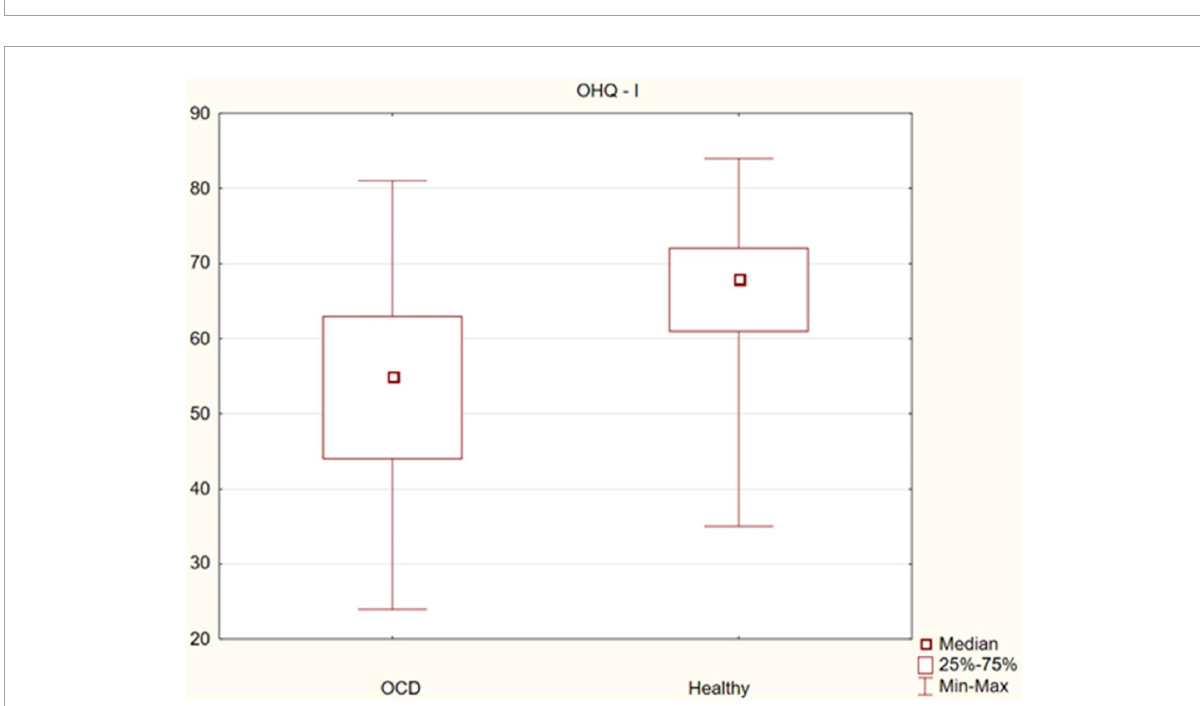
FIGURE2 Differences in life satisfaction and sense of strength between obsessive-compulsive disorder (OCD) patients and healthy controls.